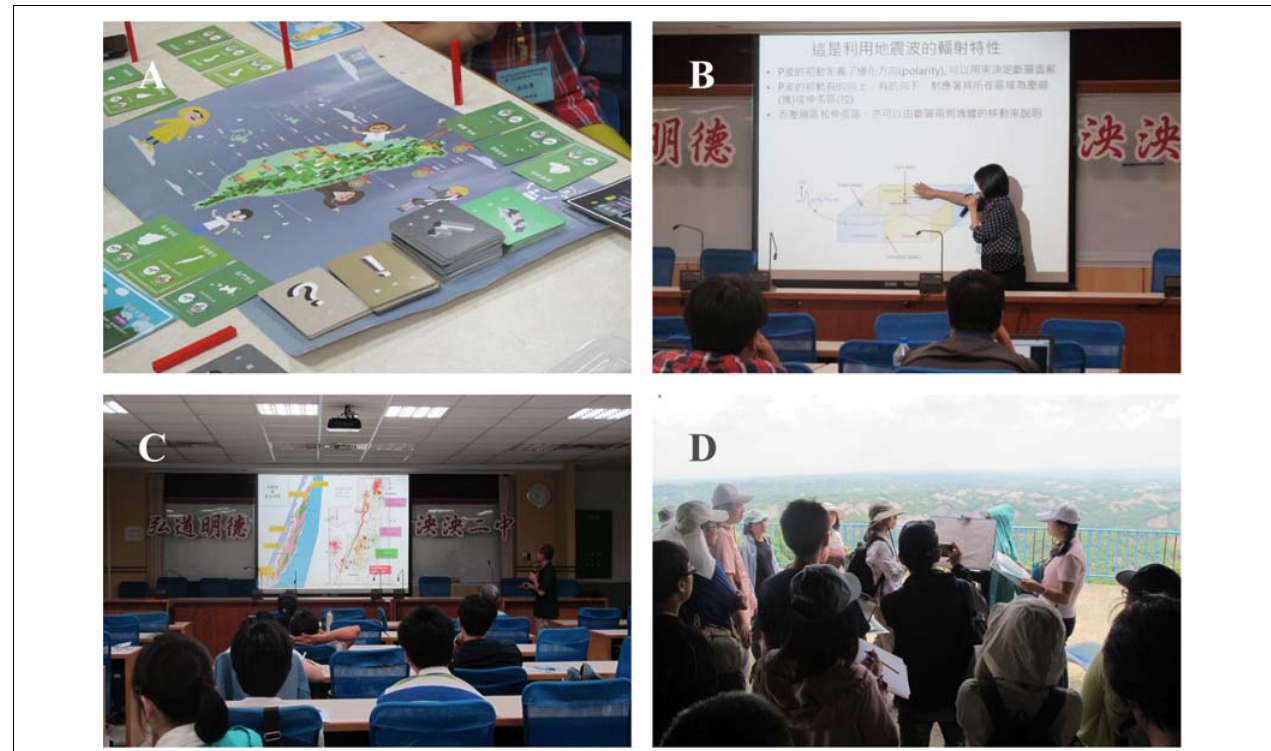
FIGURE 3 | Photographs illustrating activities and highlights of the 2017 training workshop. (A) A board game designed for learning knowledge and hazard mitigation for earthquakes and extreme weather in Taiwan. (B) Lecture introducing basic knowledge of seismology. (C) Lecture explaining active faults and earthquake triggered geohazards. (D) photograph taken in the field excursion around area of badland mudstone, where different earthquake-triggered damages could potentially occur. (Written informed consent were obtained from participants that may be identifiable in this figure).